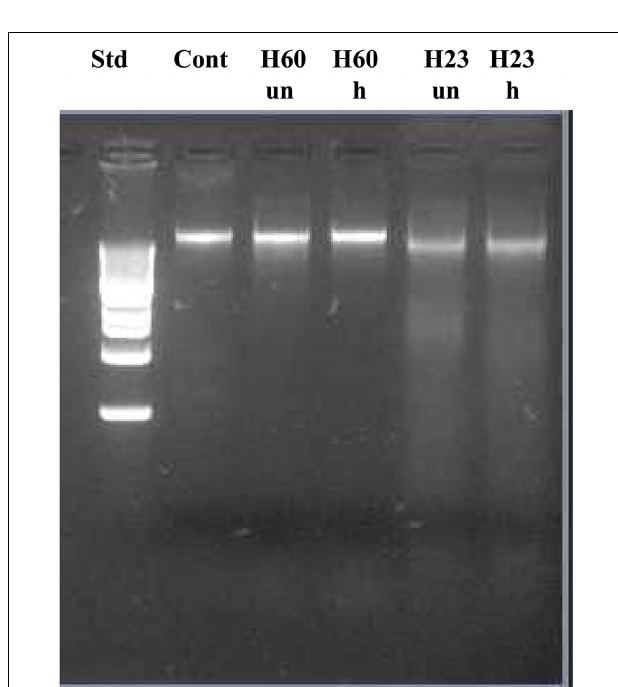
FIGURE 7 | Effect of exposure of E. coli naked DNA to unheated and heat-treated honeys H60 and H23.